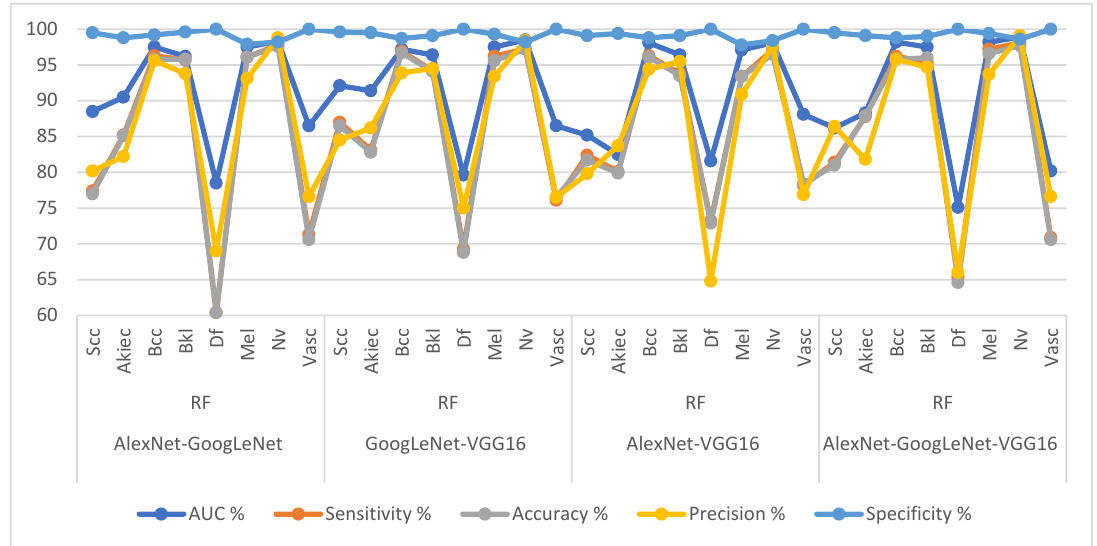
Figure 14. Display Performance results of CNN-RF hybrid models based on the fused CNN models for early diagnosis and discrimination of skin cancer and other skin lesions. The hybrid models of CNN-ANN and RF-CNN based on fusion features of the CNN model produce confusion matrices that show the performance of the hybrid models for the early detection of skin cancer for distinguishing skin cancer from other lesions.